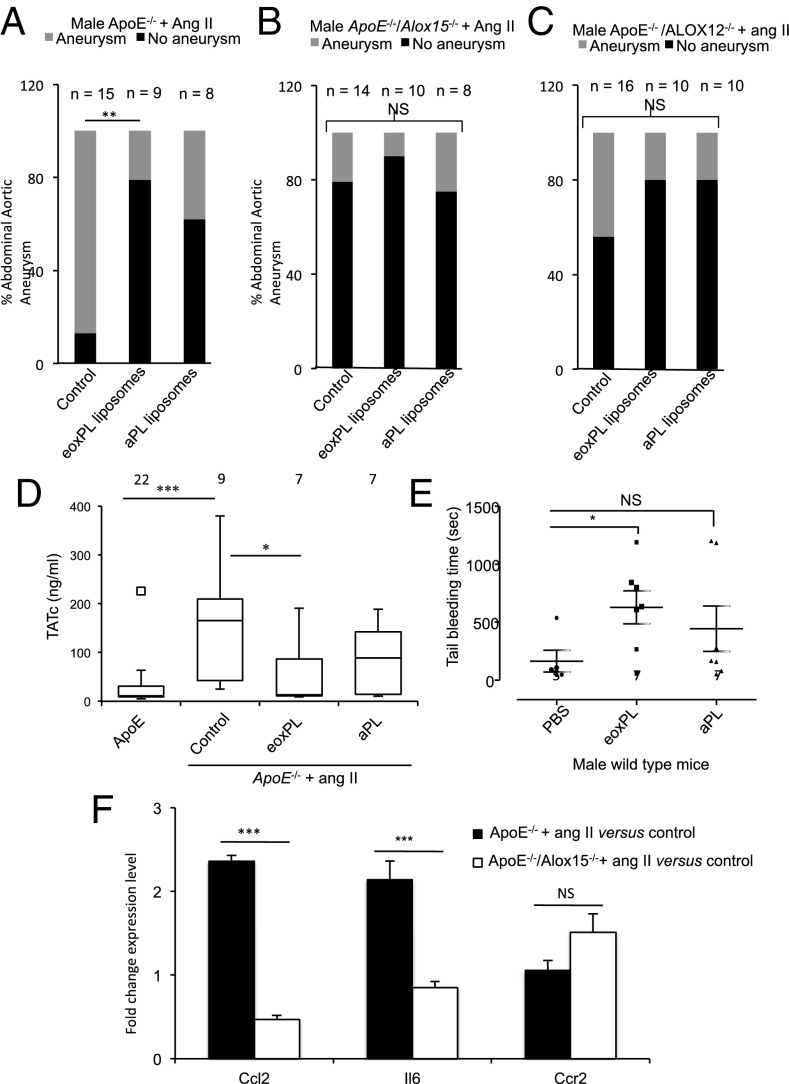
Procoagulant liposomes prevent AAA in mice, while modulating Ang II induced coagulation activities, and Alox15 deficiency is associated with decreased Ang II induction of IL6 and Ccl2. (A) eoxPL/aPL liposomes prevent AAA in ApoE−/− mice. Male ApoE−/− mice on normal chow diet aged 19–24 wk were administered Ang II as described in Materials and Methods. Liposomes (eoxPL or aPL) were administered every second day (see Materials and Methods for composition and dose). Data are expressed as percentage of mice developing AAA. (B and C) eoxPL/aPL liposomes reduce AAA in ApoE−/− mice lacking either Alox12 or Alox15. Male mice on normal chow diet aged 19–24 wk were administered Ang II with/without liposomes as in C. Data are expressed as percentage of mice developing AAA. For A–C, the full dataset of aortae are shown in SI Appendix, Figs. S3 and S8–S10). (D) eoxPL liposomes alter coagulation parameters during Ang II infusion into ApoE−/− mice. ApoE−/− 19- to 24-wk-old male mice maintained on a normal chow diet were infused with Ang II for 2 wk, and every second day, mice eoxPL or aPL liposomes were administered as described in Materials and Methods. TATs were measured by ELISA. (E) Systemic administration of eoxPL/aPL liposomes promotes bleeding in mice. Male wild-type mice (11 wk old) were anesthetized and i.v. injected with liposomes, and tail bleeding was measured after 1 h, as described in Materials and Methods. Data from A–C were analyzed using Fisher’s exact test, and data from D and E were analyzed using Mann–Whitney nonparametric u test. ***P < 0.001, **P < 0.01, *P < 0.05; NS, no significance. Data are shown on box plots (median, with whiskers representing interquartile range). (F) Alox15 deficiency reduces the Ang II-induced elevation in IL6 and Ccl2 in mouse AAA tissue. RNA was isolated from ApoE−/− AAA tissues as detailed in Materials and Methods (n = 4 for all groups) and analyzed using the RT2 Profiler PCR Array for Mouse Inflammatory Response and Autoimmunity. Data are shown as ΔΔCT, expressed as fold change between control and Ang II-treated mice, and compared using Student’s t test. ***P < 0.005.